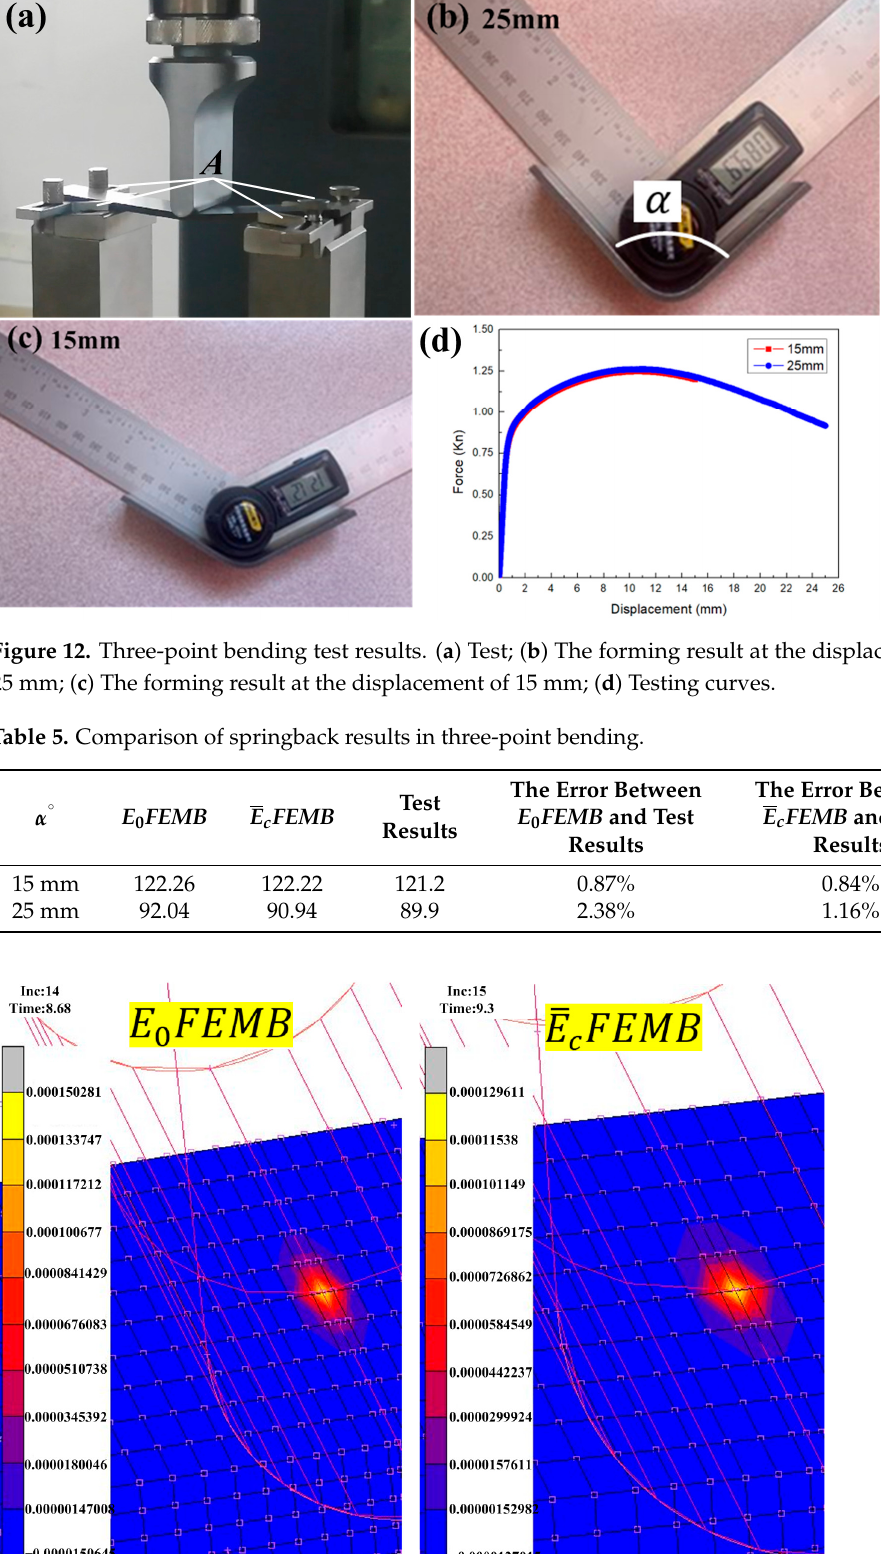
- Figure 11. Setting of the mean modulus. 4. Test Verification of the Mean Modulus Model 4.1. Three-point Bending Test To verify the accuracy of the mean modulus, the three-point bending test was carried out according to the China National Standard “Metallic materials-Determination of bending mechanical properties” (GB/T 14452-1993). The three-point bending test device was composed of a punch and two supporting dies. Two clamps were fixed on each side of the end of the specimen (Figure 12(a) A) to prevent the specimen from moving back and forth and causing instability. The length of the specimen was 120 mm; the width was